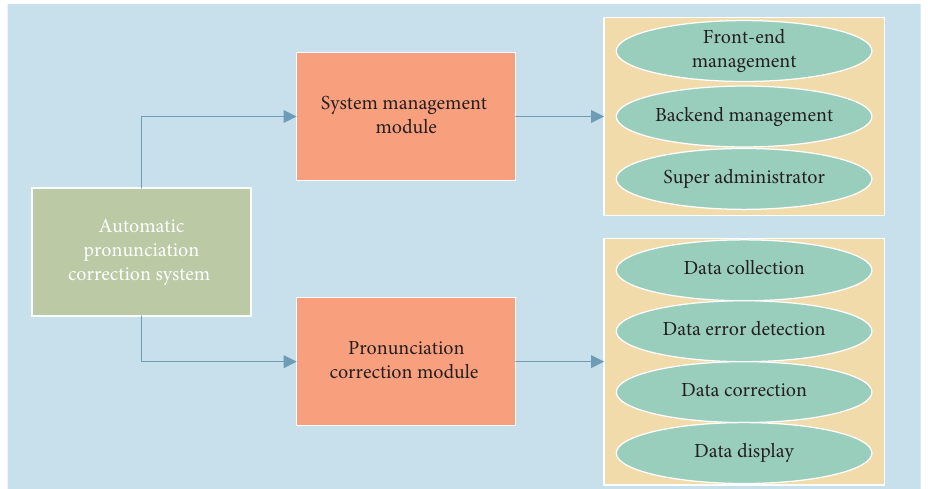
Figure 3: Functional block diagram of automatic pronunciation correction system.